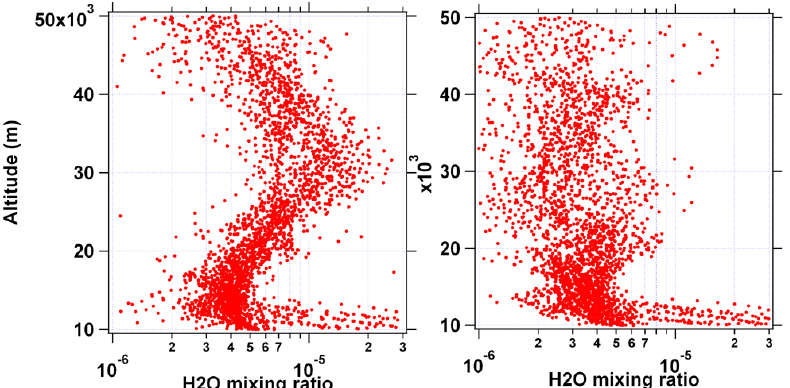
Fig. 38. Comparison of the H 2 O mixing ratios found with the official algorithm V6.0 (left) and the new Level 1B algorithm V7.0 (right). This series of occultations of star Canopus over one month covered latitudes from 23 ◦ S to 5 ◦ S. The bump at 30km has completely disappeared (right) with the new version of the algorithm (from Bertaux et al.,